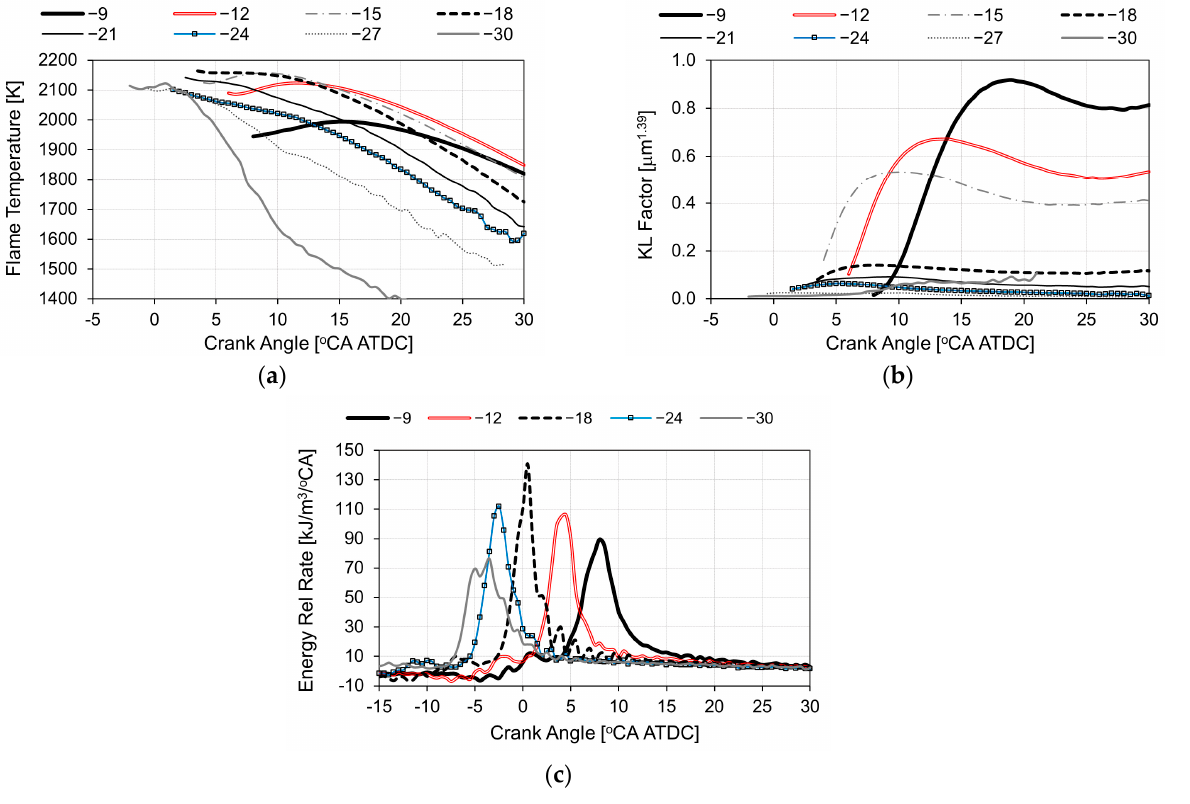
Figure 7. Flame temperature ( a ), KL factor ( b ) and energy release rate ( c ) during an SOI sweep for the 8 mg/cycle fuelling quantity at 54% EGR. the 8 mg/cycle fuelling quantity at 54% EGR.